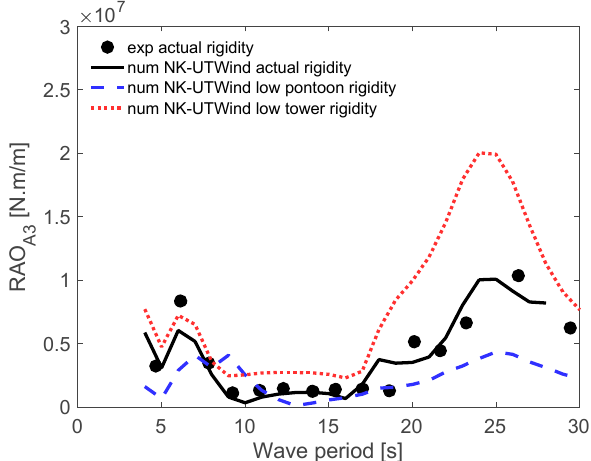
base gage (F1), and its comparison between the experiment and calculation.